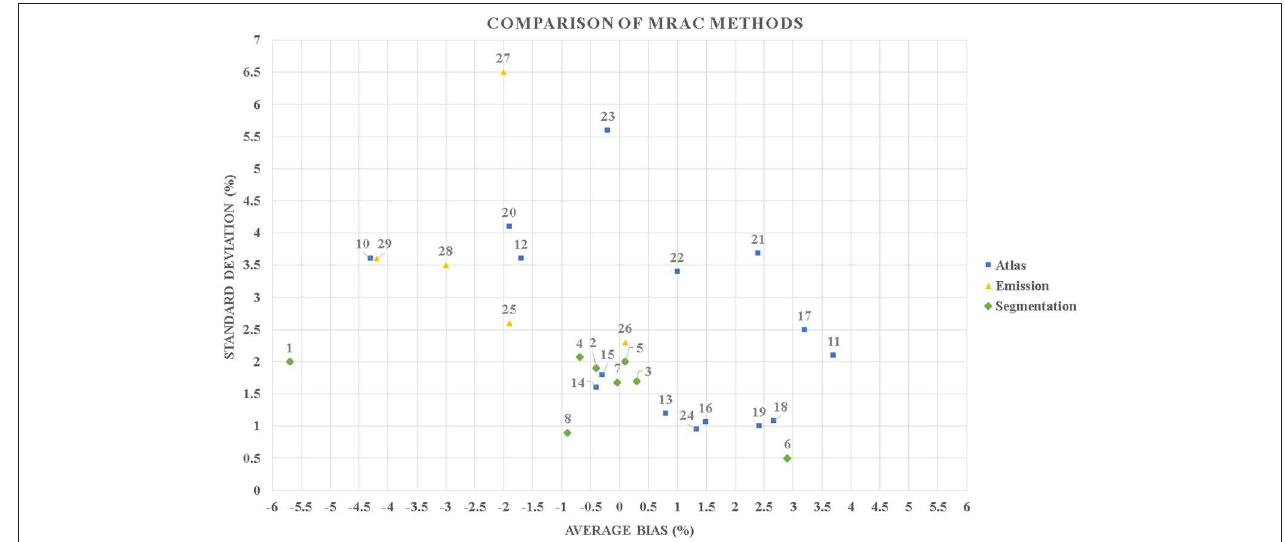
FIGURE 1 | A scatter plot diagram that contains the reported global average bias and standard deviation in percentage of the methods included in this review. It can be seen that majority of the published methods perform with a mean bias up to ± 5% in positron emission tomography (PET) evaluation. Most of the methods also have a mean bias in the range of the difference ( − 6 to + 4%) to what was previously reported in a phantom study between different positron emission tomography/computed tomography (PET/CT) and positron emission tomography/magnetic resonance (PET/MR) systems [31]. Segmentation-based methods: 1–4 [30] MR-AC DIXON , MR-AC UTE , MR-AC CAR − RiDR , MR-AC RESOLUTE ; 5 [32] 6-class discrete; 6 [33] ZTE; 7 [34] ZTE; 8 [35] ZTE; 9 [36] ZTE. Atlas-based methods: 10–15 [ 30]